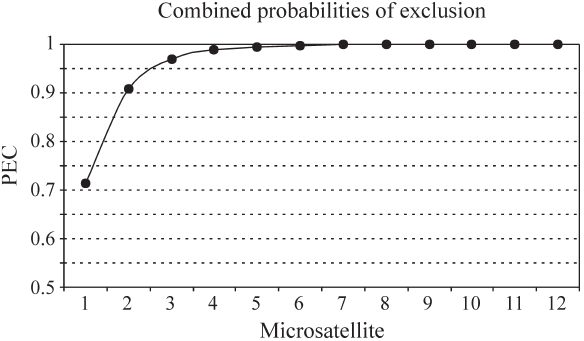
Figure 1 - Combined exclusion as a function of the number of micro- satellite loci. PEC = probability of exclusion.